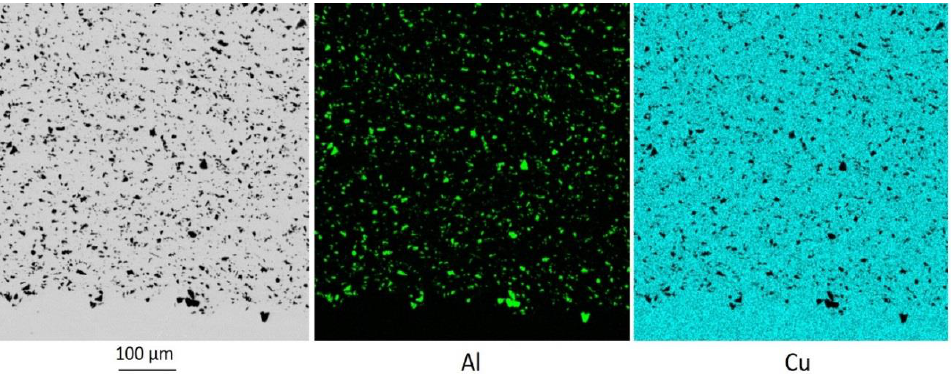
Figure 3. The microstructure and distribution maps of elements of the cold-sprayed Cu-60% Al 2 O 3 coating without preprocessing.